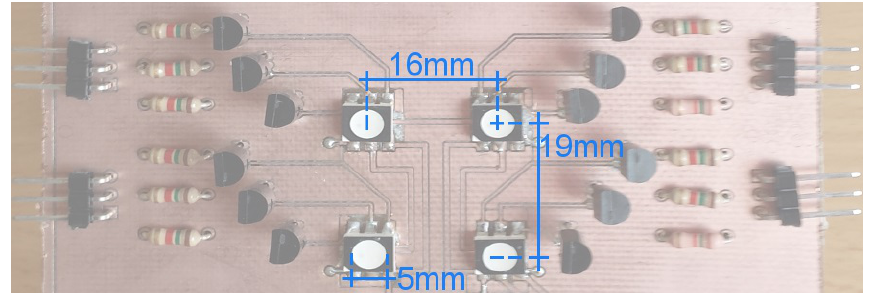
Figure 5. Designed LED’s Board with the distances between its